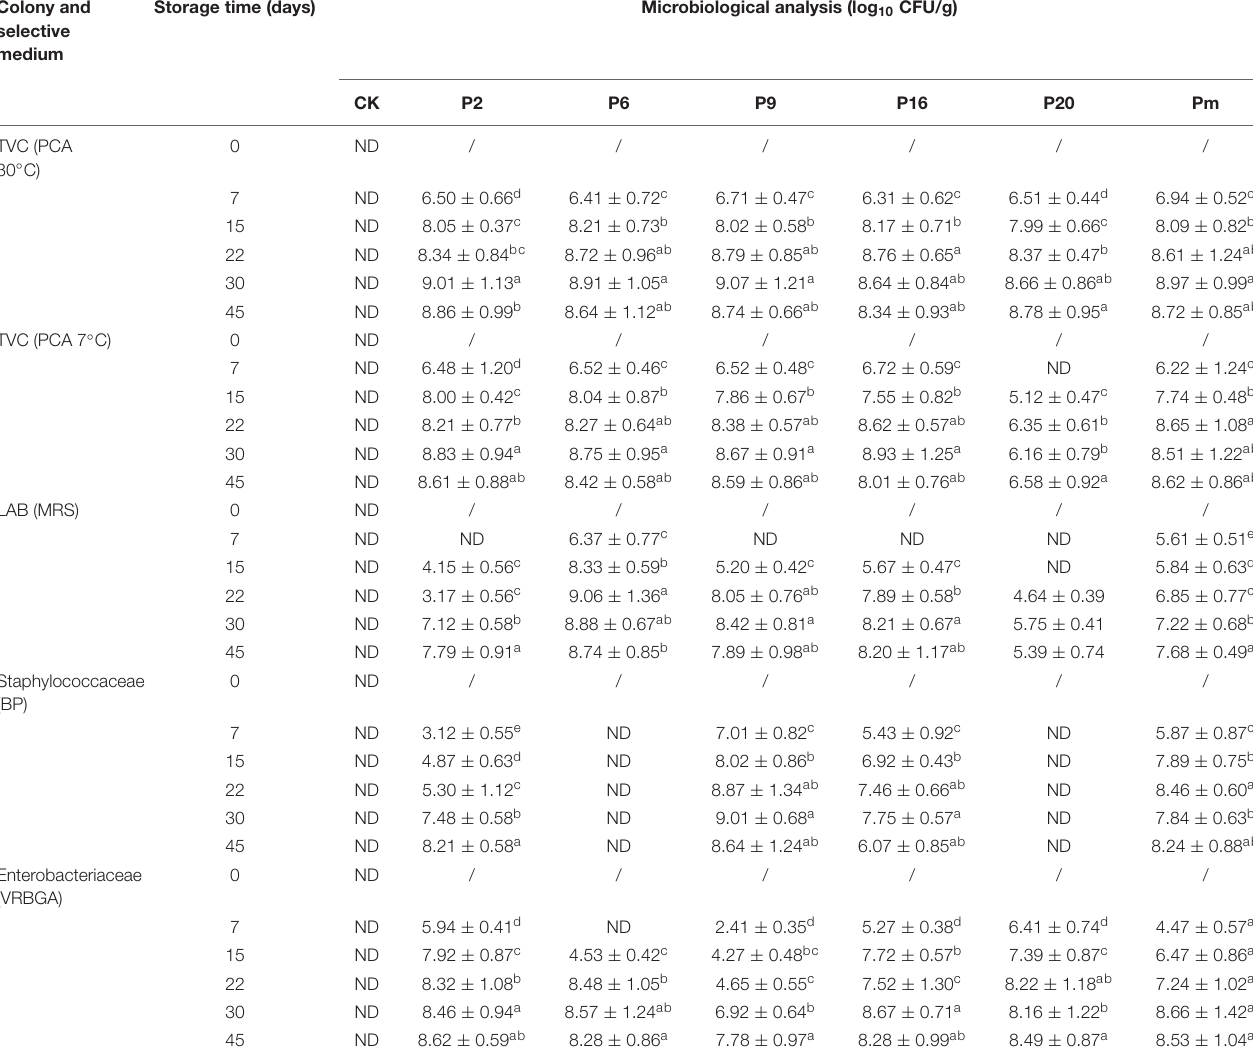
TABLE 2 | Changes in viable counts of bacon inoculated with potential spoilage bacteria, during refrigerated storage after 45 days. Colony and selective